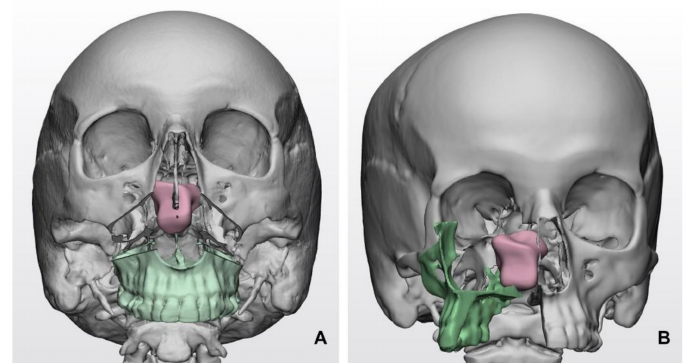
Figure 1. Simulated transfacial accesses using virtual models in clival meningiomas: ( A ) Le Fort I transmaxillary access; ( B ) transfacial maxillary-split approach. The bone flap is represented in green color, while the tumor mass is represented in pink